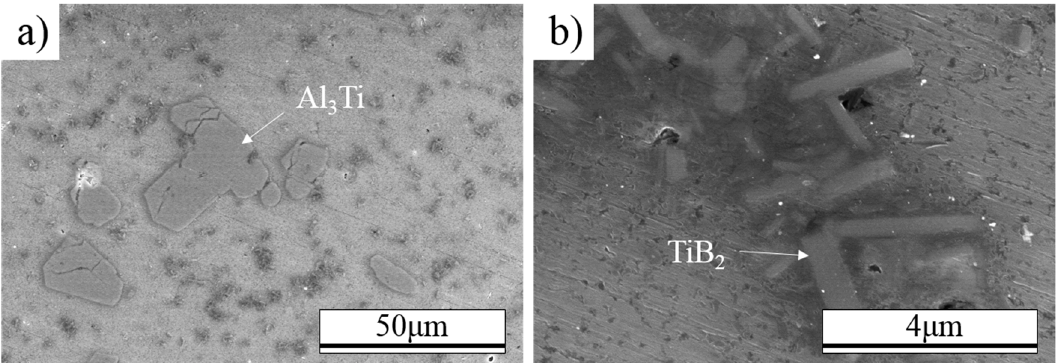
Figure 8. SEM images of the Al-5Ti-1B master alloys ( a ), high resolution ( b ).